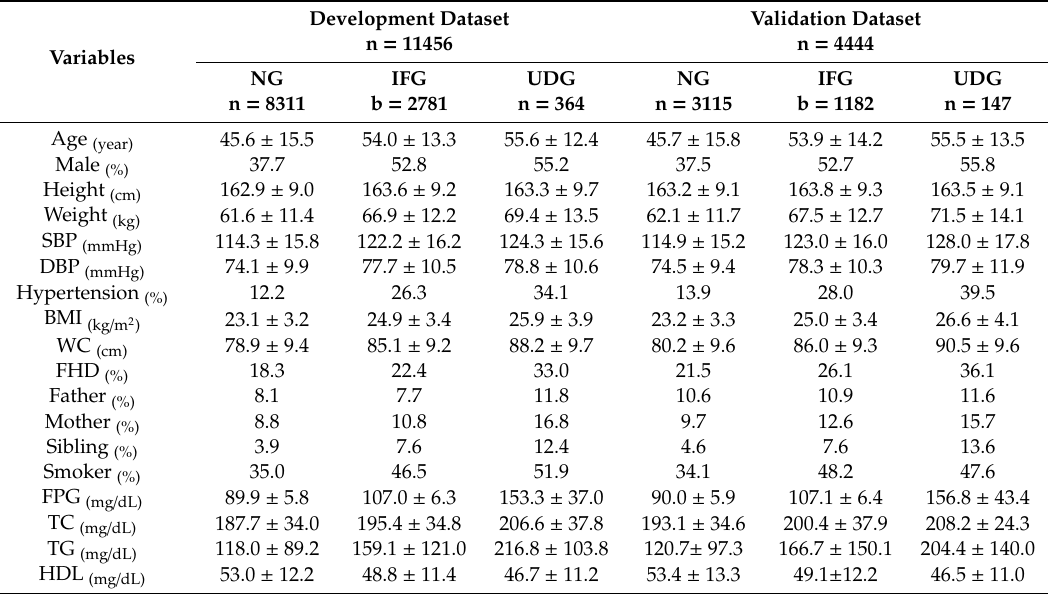
network model in Table 2. All reported p -values are two-sided, and significance was set as a p -value of < 0.05. Table 1. Basic characteristics of participants for the development and validation dataset.